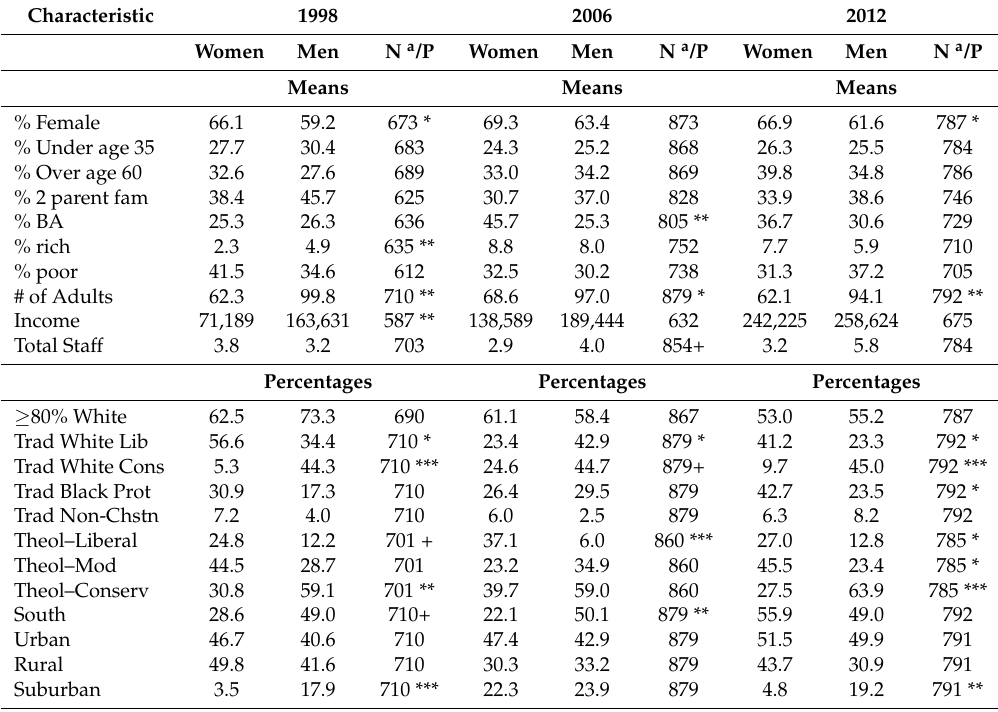
Table 3. Congregation Characteristics—Descriptive Statistics and Bivariate Analyses.